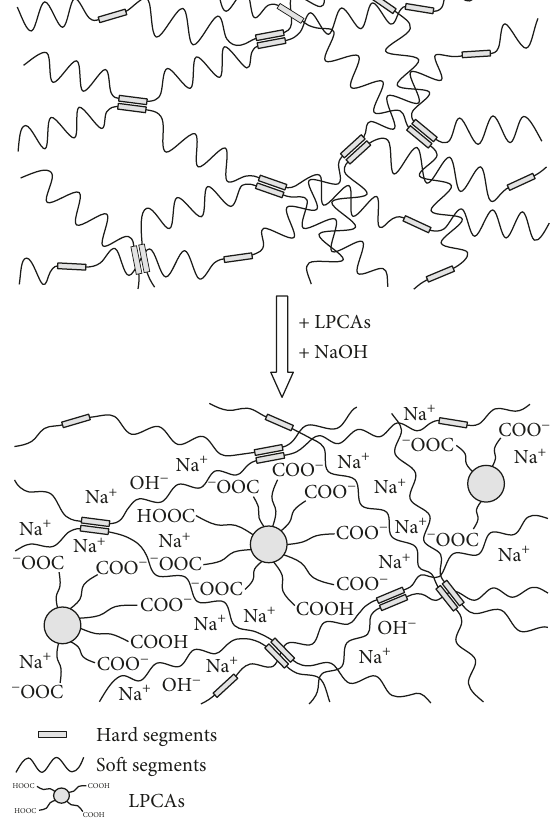
Figure 3: Illustration of interactions between LPCAs and WPU